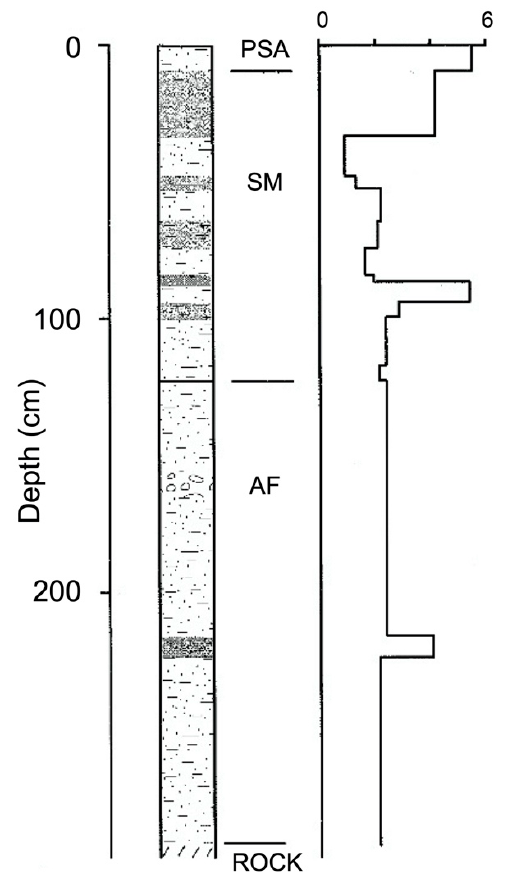
Figure 6. Stratigraphic profile and Loss on Ignition (%) at cross-section 4 on Takalarup Creek. PSA = Post Settlement Alluvium, AF = Alluvial Fill, SM = Swampy Meadow. The vertical axis is in cen- timetres.